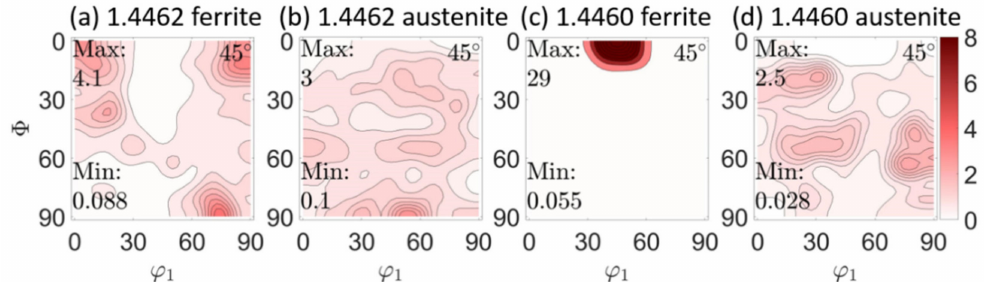
Figure 3. ϕ 2 = 45 ◦ —projections through the orientation distribution functions (ODF) in the initial states of both duplex stainless steels. ( a , b ) for steel 1.4462 for the ferrite and the austenite phase, respectively and ( c , d ) for steel type 1.4460 for the ferrite and the austenite phase,